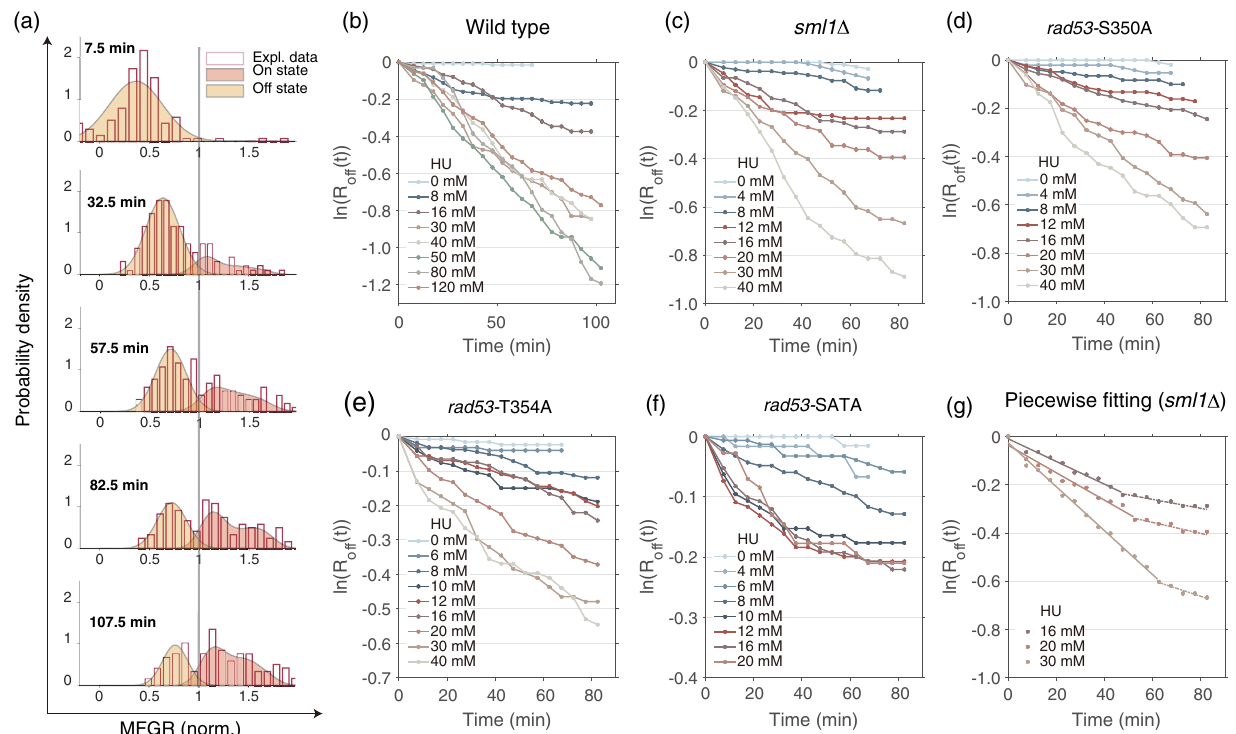
FIG. 3. Dynamic properties of MFGR of Rnr3 protein with respect to DNA replication stress in WT, sml 1 Δ , rad 53 -S 350 A, rad 53 -T 354 A, and rad 53 -SATA strains. (a) Bimodal probability distribution of maximum Rnr3 growth rate for HU ¼ 80 mM at different times in WT yeast cells. As time evolves, the proportion of off-state cells decreases while the proportion of on-state cells increases, indicating the dynamic transition from off to on states. (b) – (f) Inactivation curve for different HU dosages in WT (b), sml 1 Δ (c), rad 53 -S 350 A (d), rad 53 -T 354 A (e), and rad 53 -SATA (f) mutants. The y label denotes the logarithm of the off-cell proportions, and the x label denotes time, forming the inactivation curves for the DNA replication-stress-responsive switching process. The curve consists of a linear region and a constant region, implying the exponentially distributed stochastic responsive switching in the S phase and the termination of switching after the S phase. With the increase of HU concentration, the switching rate increases. It also suggests that the S-phase period of yeast cells under low HU concentrations is shorter than that of the high HU concentrations. (g) Linear decay (indicated by solid lines) and stationary regime (indicated by dotted lines) by piecewise linear fitting in sml 1 Δ